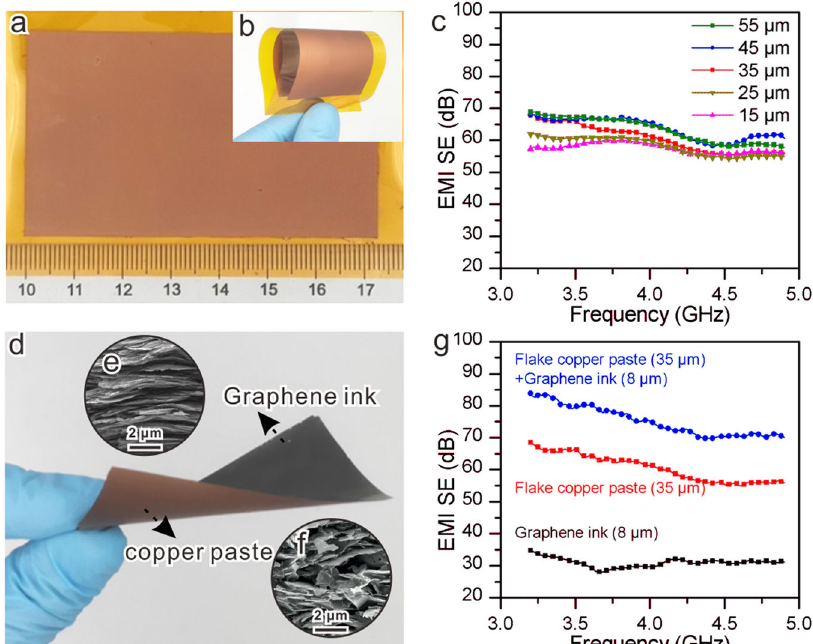
Fig. 4 Characterization of EMI shielding fi lms. a Image of the fi lm printed with copper paste on PI substrate. b Bending display of the fi lm. c EMI SE of copper paste fi lms at different thicknesses. d Image of the fi lm printed with fl ake copper paste and graphene ink. e Cross-sectional SEM image of the graphene ink layer. f Cross-sectional SEM image of the copper paste layer. g EMI SE of fi lms printed with different